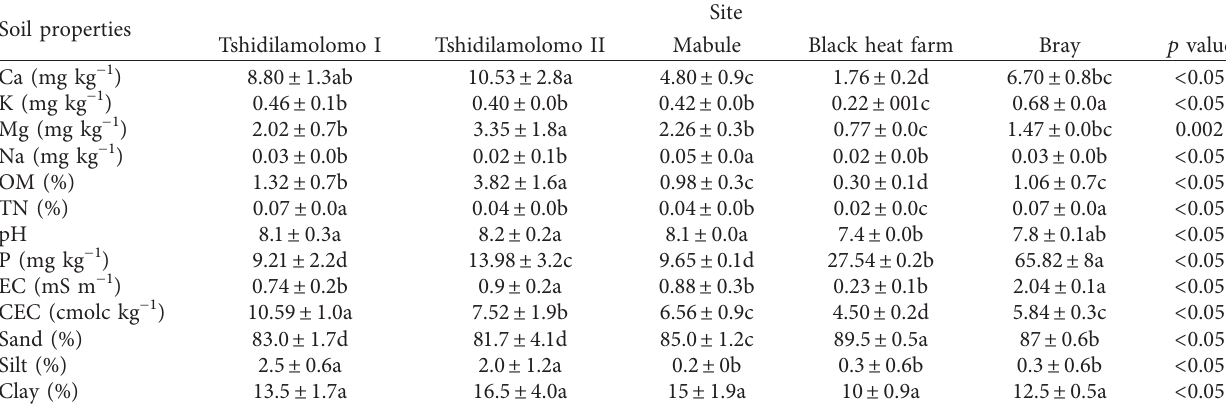
Table 3: Mean ( ± SEM) of selected soil properties in invaded Prosopis stands at five study sites. Soil